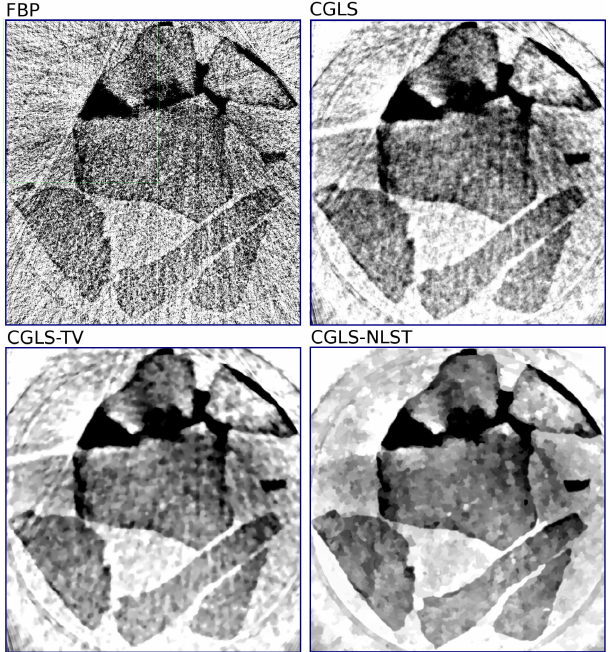
Figure 6. Reconstruction from 60 projections to show the difference iterative methods can make to resolving key spatial information in fluid flow studies. The images show an axial slice (1000 × 1000 pix- els) from one time frame of a 4-D experiment performed at ICON. The darkest areas depict the different times showing the progress of water entering the sample. The mid-gray regions are gravel particles which have approx. 10% internal porosity.